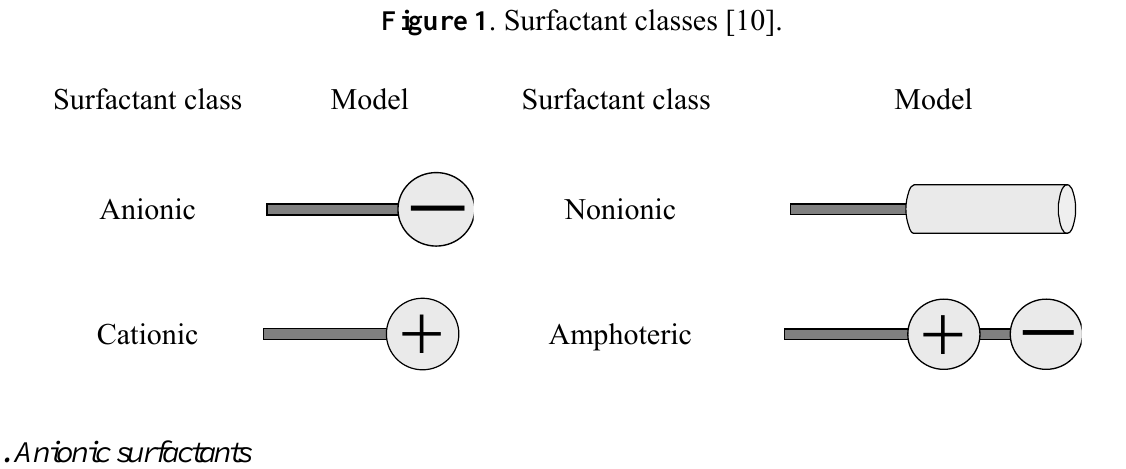
Figure 1 . Surfactant classes